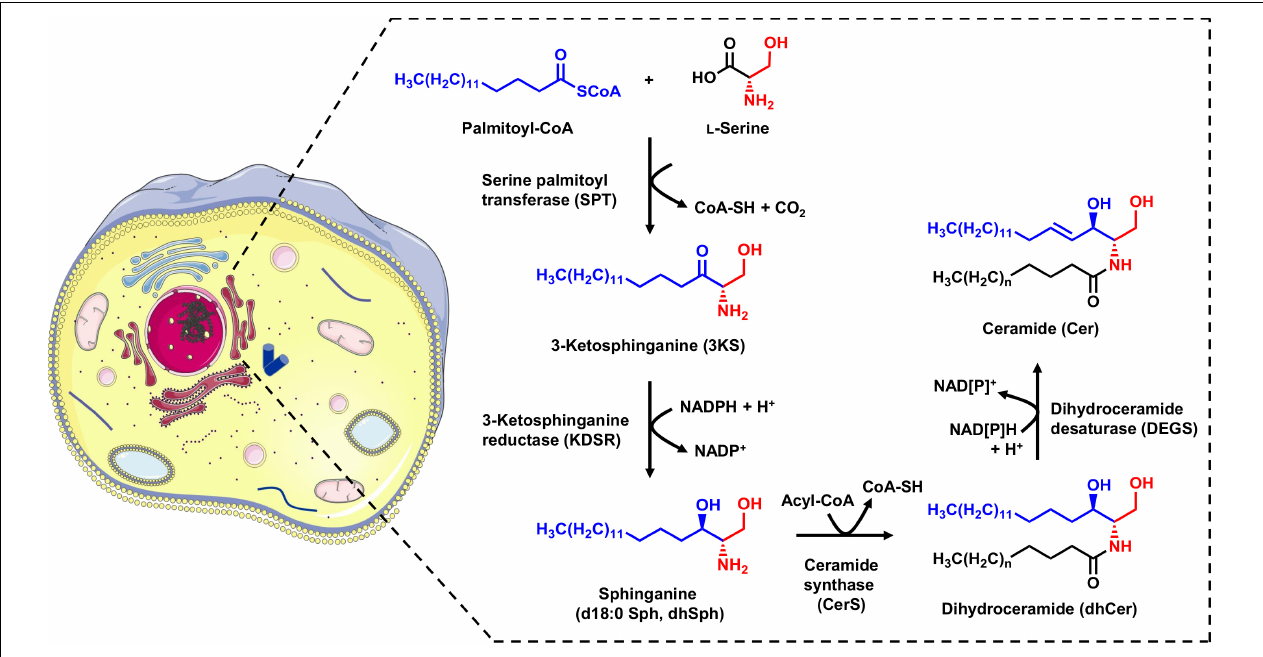
FIGURE 1 | Schematic overview of the sphingolipid de novo synthesis located in the ER. Serine palmitoyltransferase (SPT) catalyzes the condensation of palmitoyl-CoA and L -serine. The product of this reaction, 3-ketosphinganine (3KS), is further NADPH-dependently reduced to sphinganine (dihydrosphingosine, d18:0 Sph) by 3-ketosphinganine reductase (KDSR). Ceramide synthases (CerS) couple fatty acyl-CoAs to the amino group of the long-chain base d18:0 Sph. This leads to the formation of dihydroceramides (dhCer), differing in the chain length of the amide-bound fatty acid. The final step is the introduction of a double